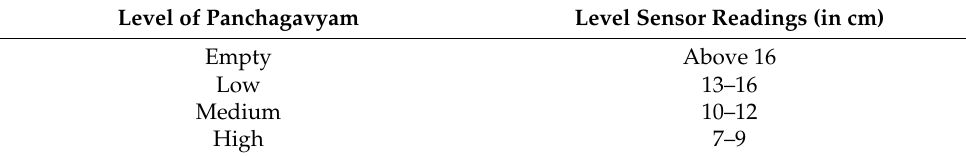
Table 3. Ultrasonic-level sensor